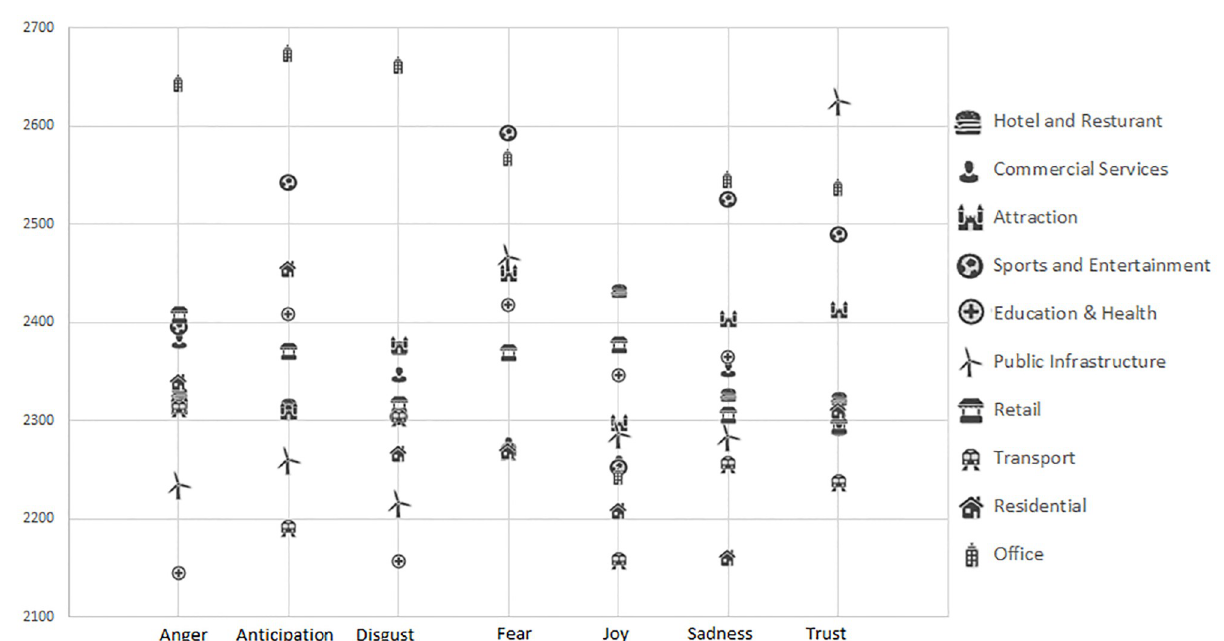
Fig 7. The emotions displayed for different location categories in San Francisco (based on the mean rank. A higher rank denotes a higher level of emotion).